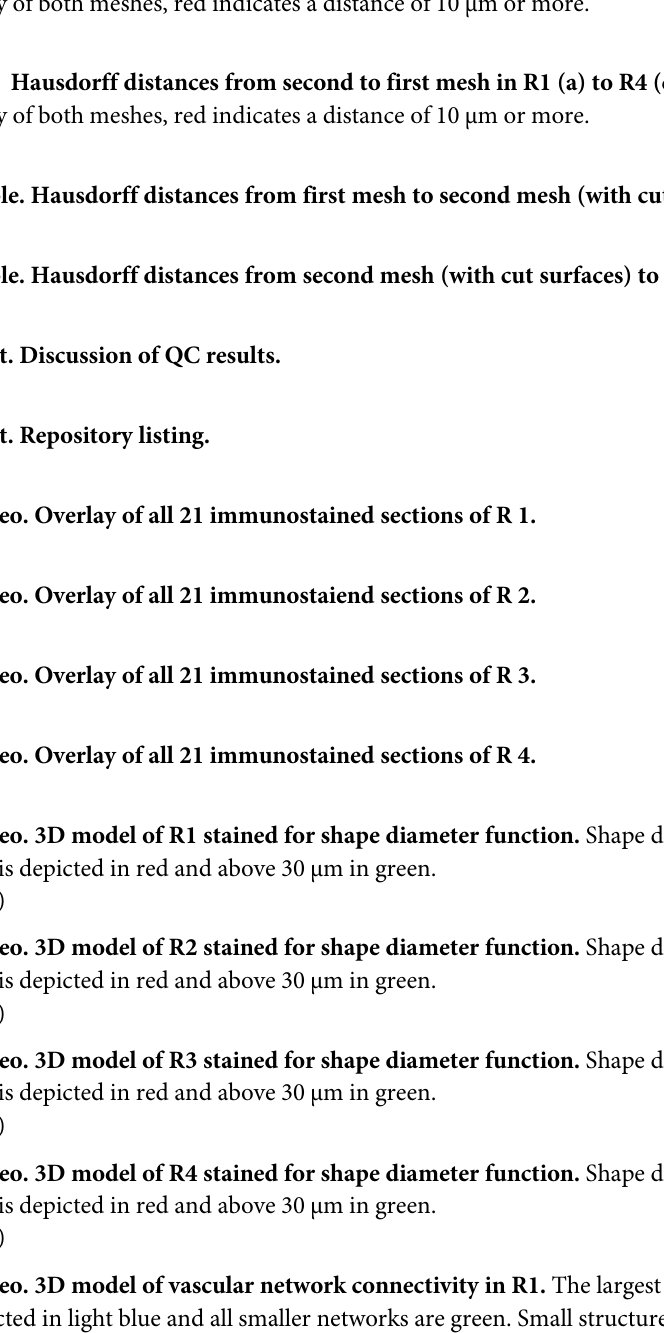
S2 Fig. Hausdorff distances from first to second mesh in R1 (a) to R4 (d). Blue represents identity of both meshes, red indicates a distance of 10 μm or more. (TIFF) S3 Fig. Hausdorff distances from second to first mesh in R1 (a) to R4 (d). Blue represents identity of both meshes, red indicates a distance of 10 μm or more. (TIFF) S1 Table. Hausdorff distances from first mesh to second mesh (with cut surfaces) (XLS) S2 Table. Hausdorff distances from second mesh (with cut surfaces) to first mesh. (XLS) S1 Text. Discussion of QC